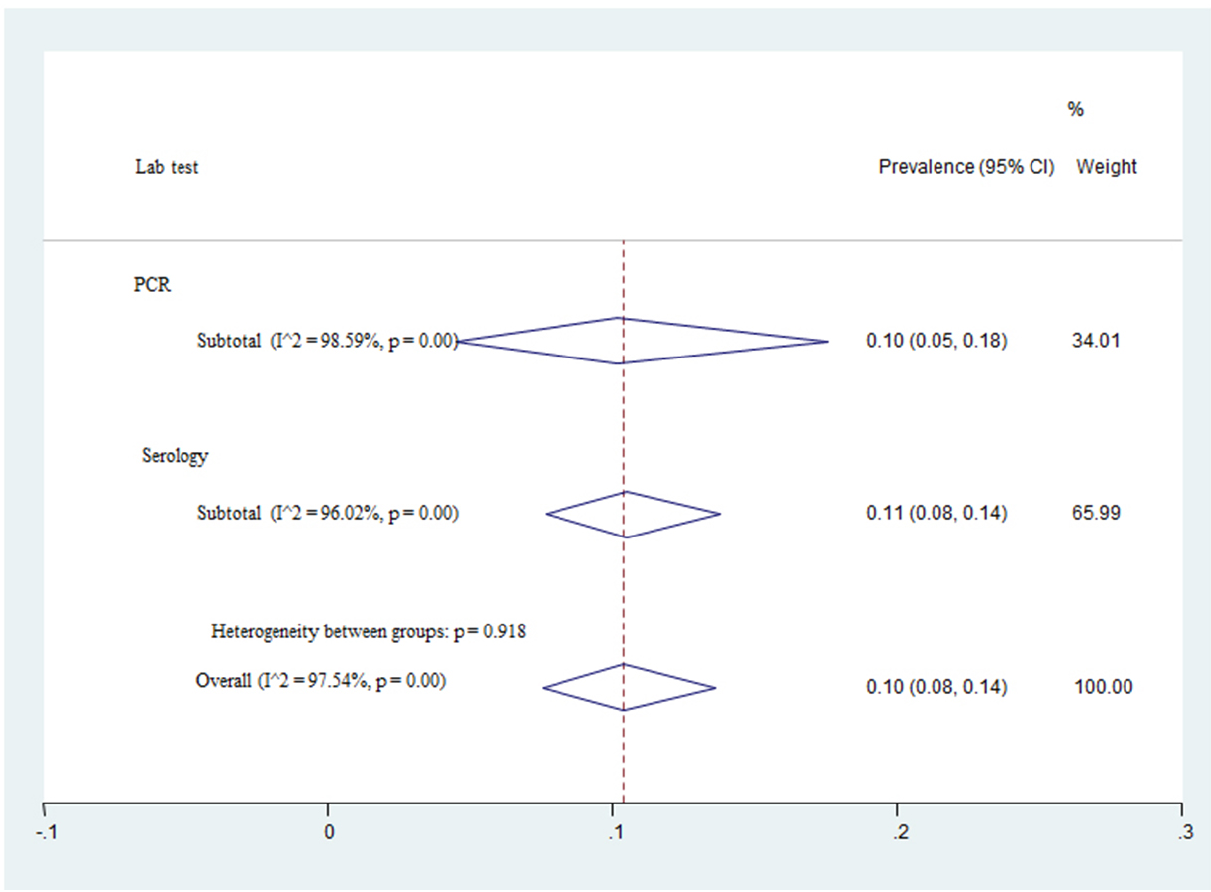
Figure 2. Forest plot for the prevalence of Leishmania infection in cats by PCR and serology tests.